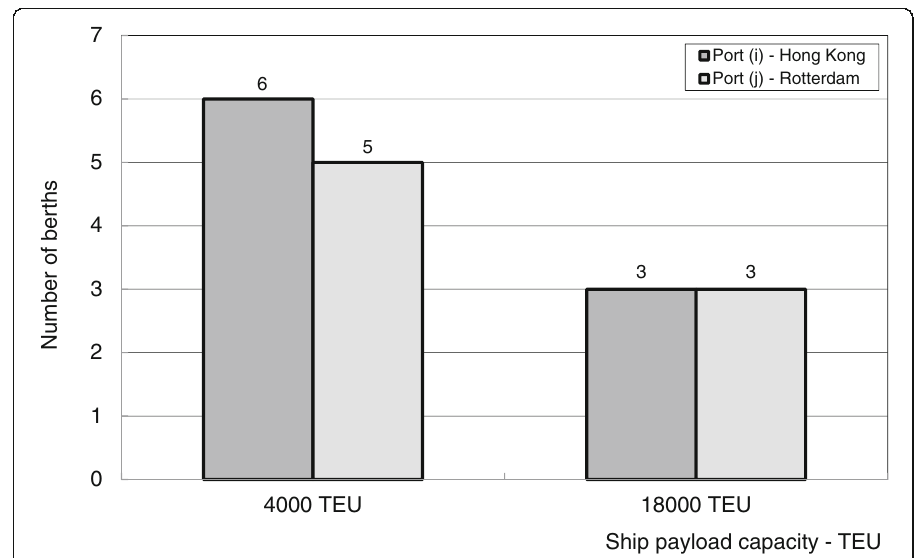
Fig. 8 The indicators of infrastructural performances of the trunk line/route - Number of berths in